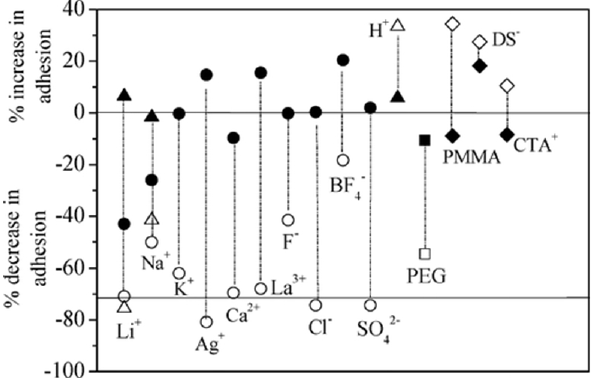
Figure 15. Changes in ice-adhesion for different ions incorporated in polyelectrolyte brushes. Filled symbols represent measuremenst at − 18 ◦ C, while open symbols represent measurments at − 10 ◦ C. Reprinted with permission from Ref. [153]. c (cid:13) 2014 American Chemical